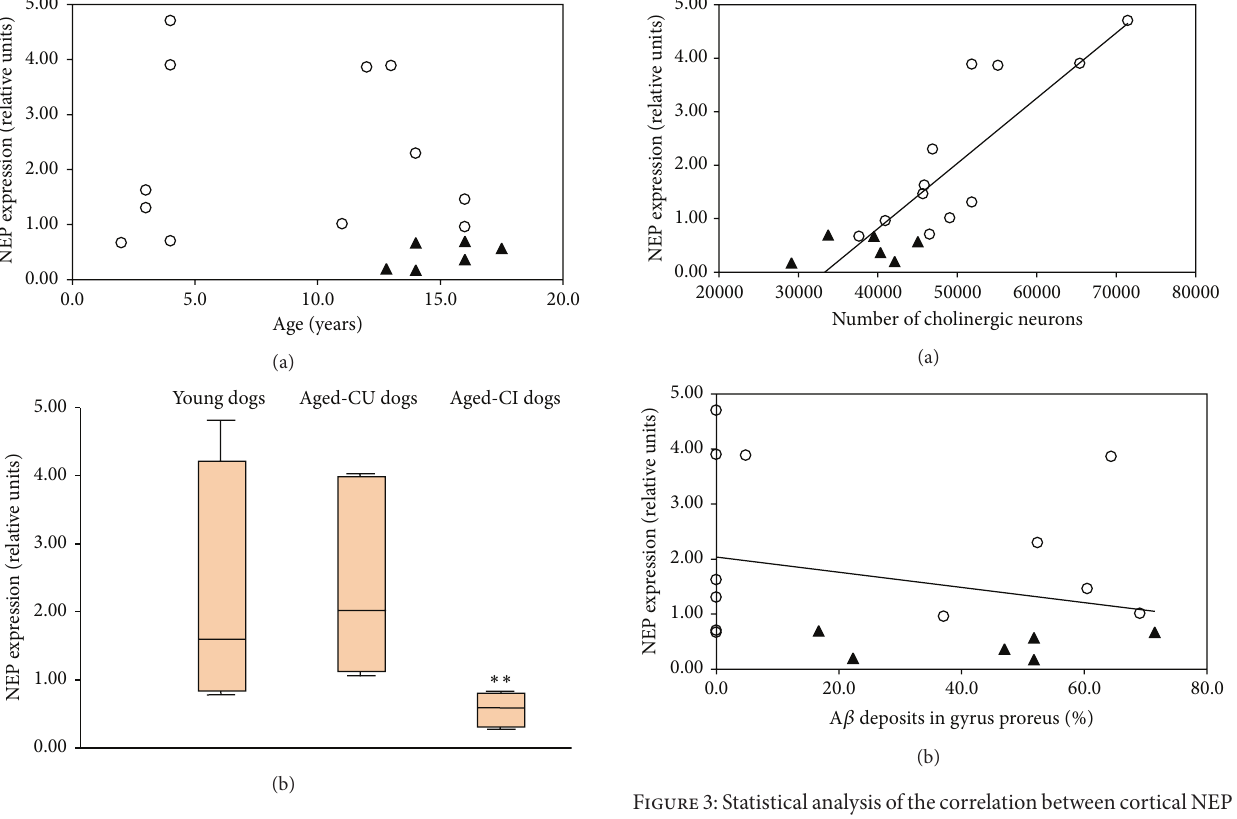
Figure 2: Diagrammatic representation of dog NEP expression. (a) Relative quantification of brain NEP expression in dogs (cognitively healthy (o), both young and aged, and aged-cognitively impaired ( 󳵳 )) is presented as a function of age. (b) The box-and-whisker plot showed a larger dispersion in young and aged-CU dogs than in the aged-CI dogs. ∗∗ indicates 𝑃 < 0.01 with regard to both, aged-CU and young dogs.